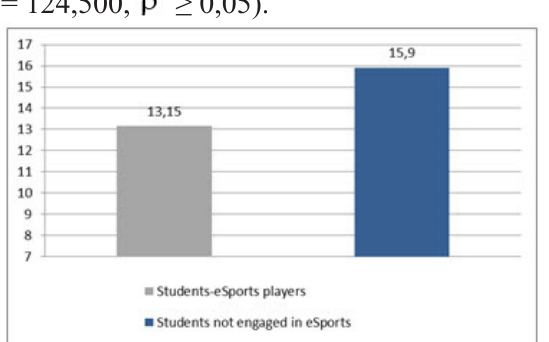
Figure 3. Results of diagnostics of the level of critical thinking of students-eSports players and students that are not involved in